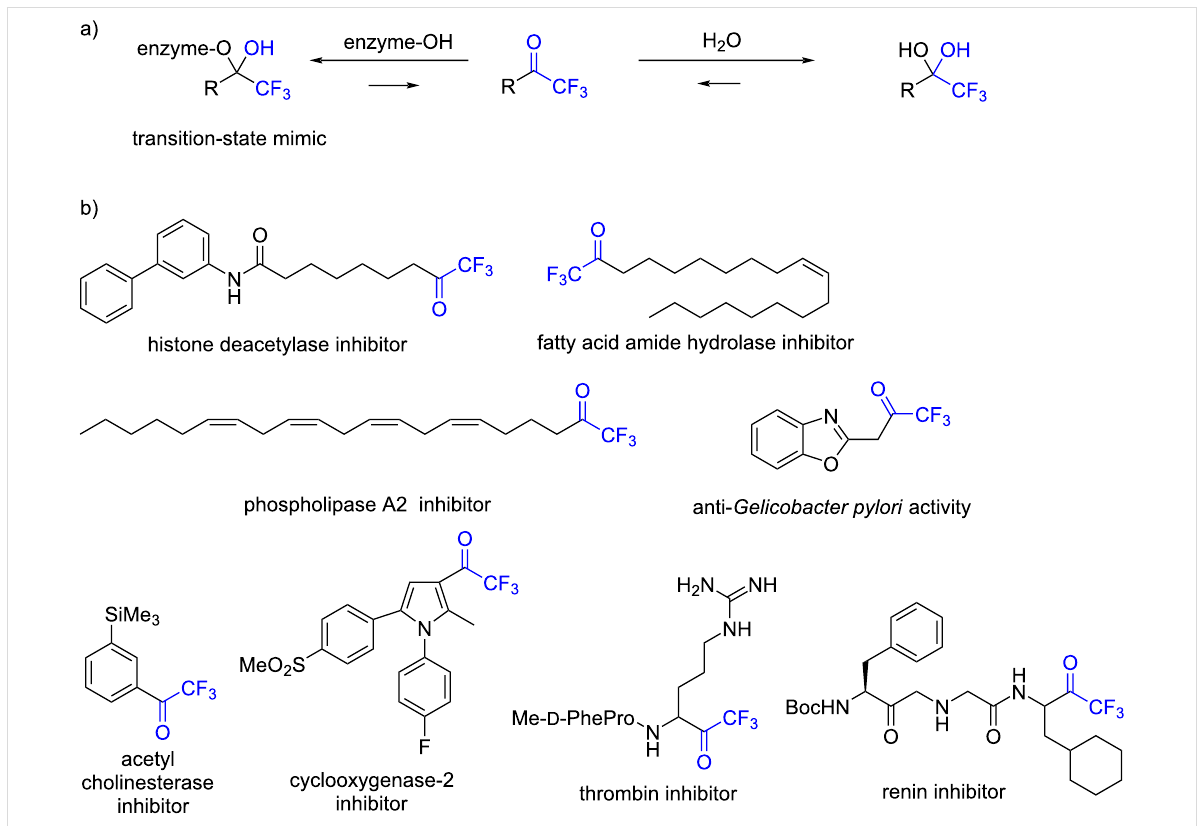
Figure 1: Trifluoromethyl ketones. a) Hydrolysis of trifluoromethyl ketones. b) Selected examples of biologically active trifluoromethyl ketones.